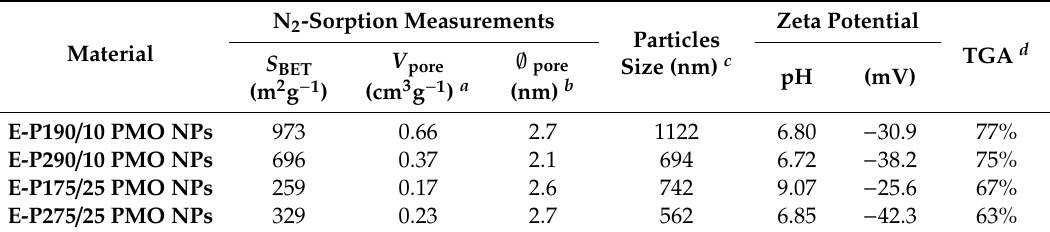
Table 1. Some data of E-Pn PMO NPs .